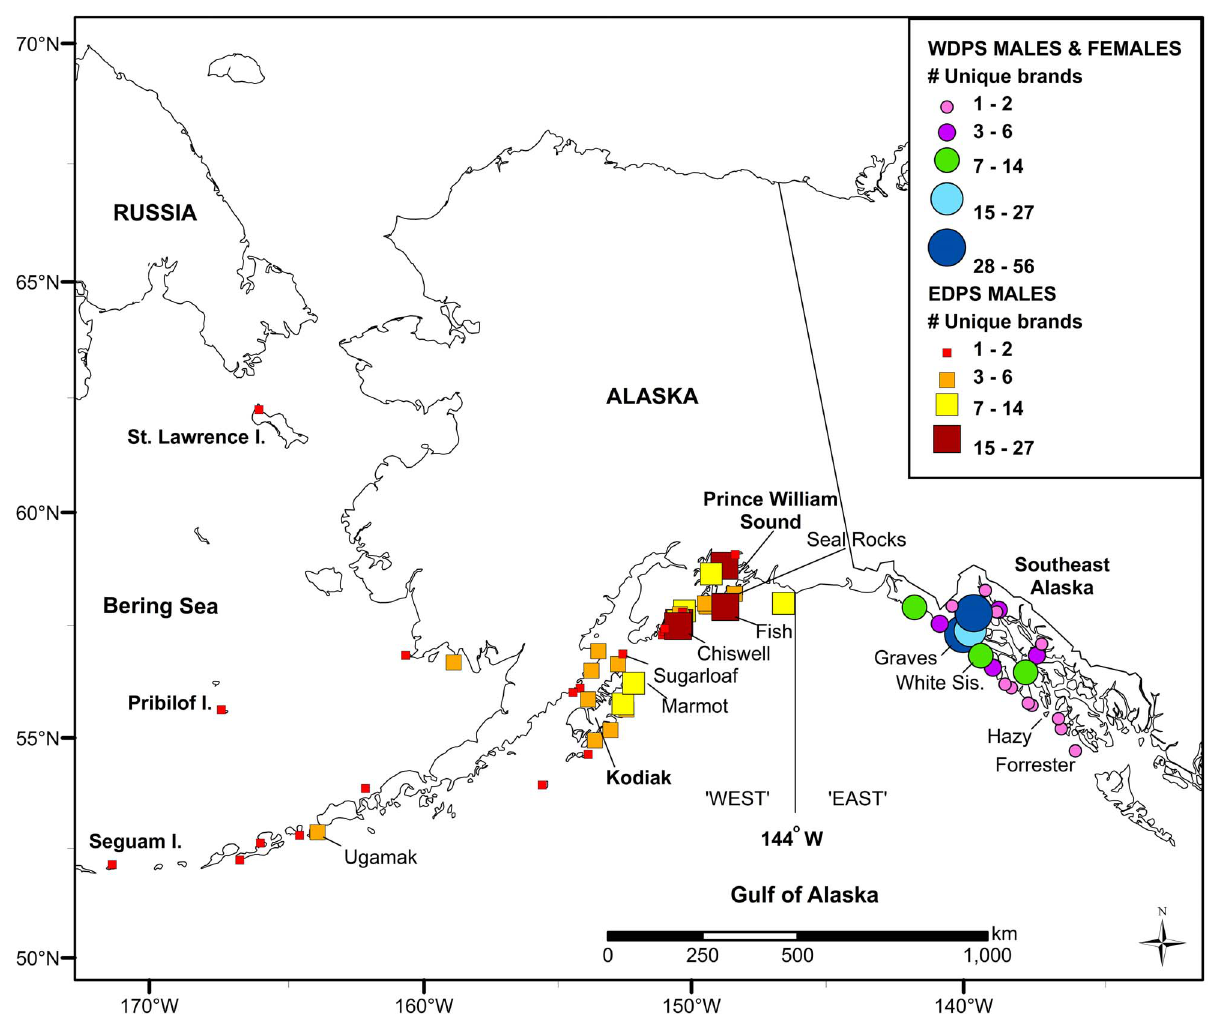
Figure 3. Location and number of individual Steller sea lions resighted in their non-natal DPS. Squares show location of eastern Distinct Population Segment (DPS) males in the West and circles represent western DPS male and female sea lion locations in the East. Not included on map are observations of a male WDPS SSL that was resighted in northern Washington.